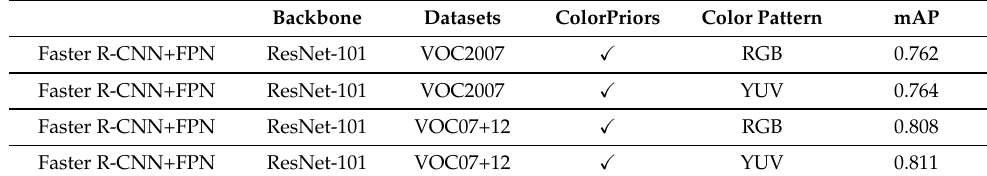
Table 3. Performance comparison of object detection algorithms using different color spaces.